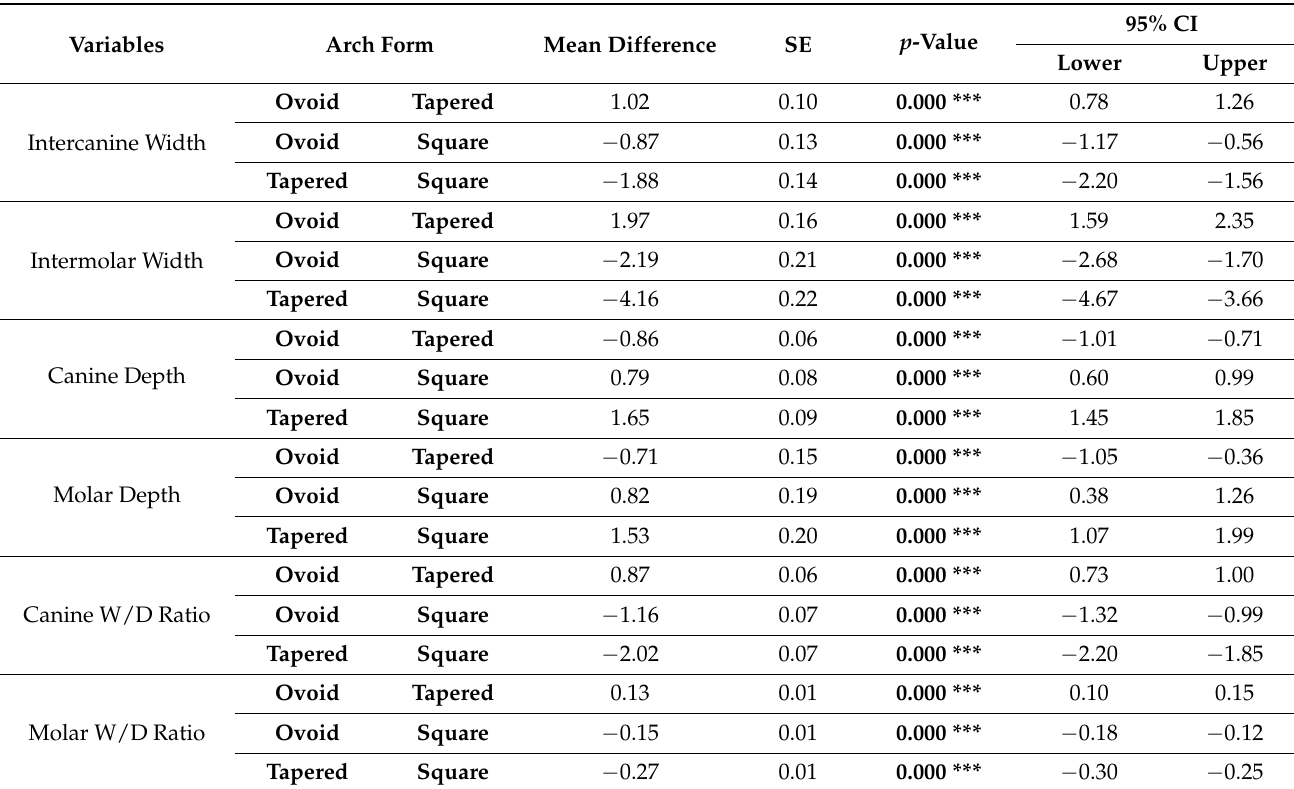
Table 8. Post hoc Tukey HSD test showing the comparison of arch dimensions between two of each arch